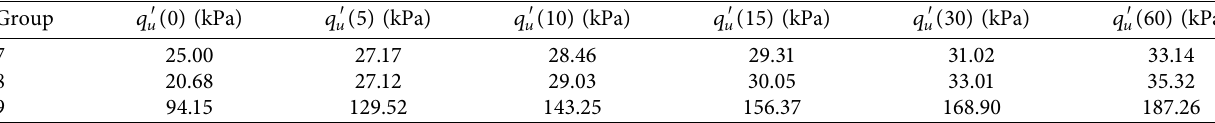
Table 11: Strength at different curing times of clay of the literature